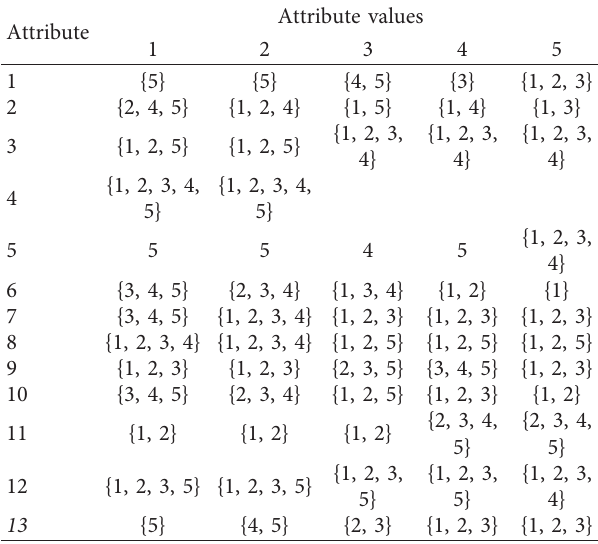
Table 11: Support sets of the attribute values of the Boston housing dataset for a customer having high customer satisfaction (5). The